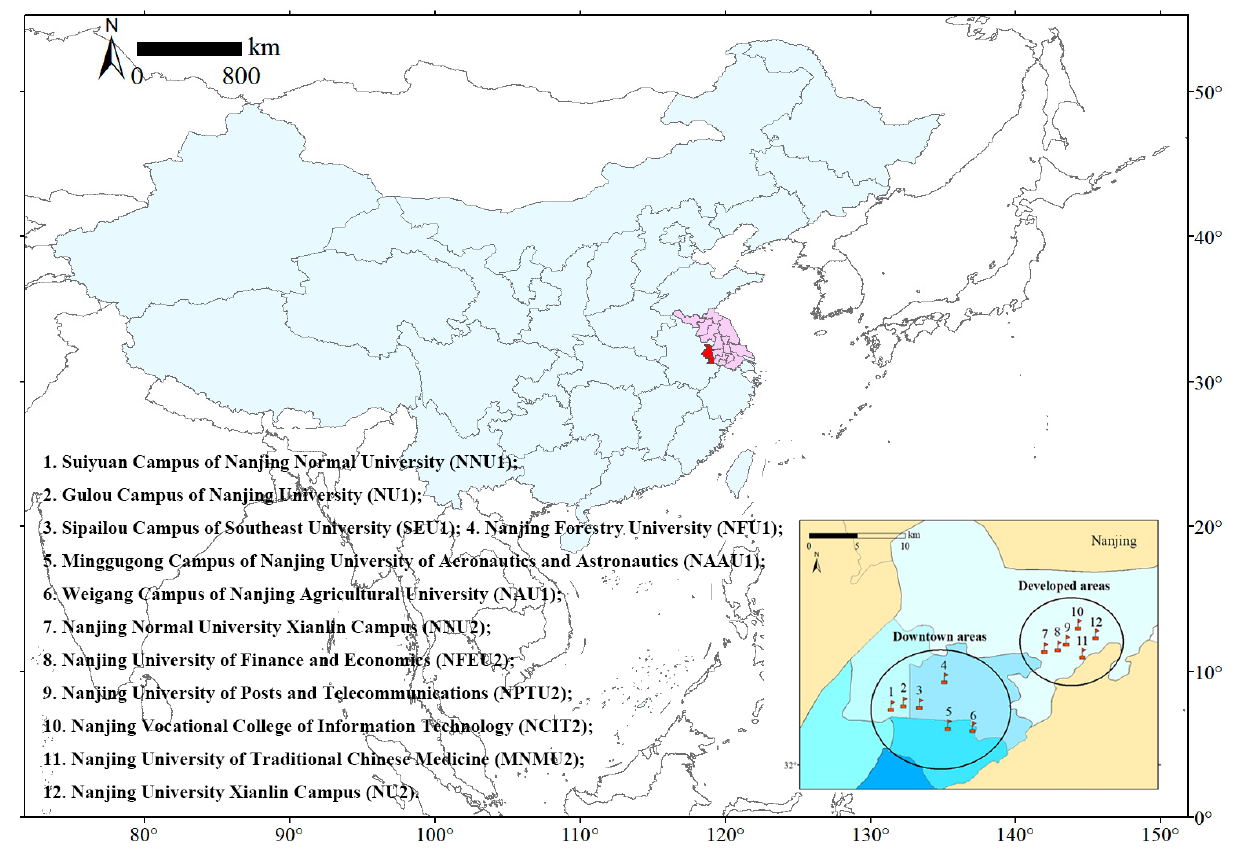
Figure 1. The geographic location of Nanjing in China and the distribution of the 12 university campuses studied for this paper.